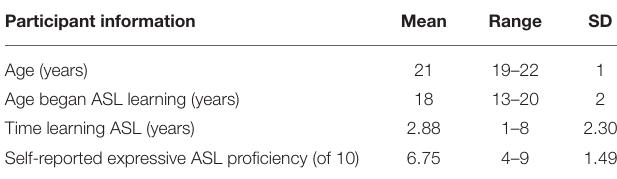
TABLE 1 | The L2 signers’ background